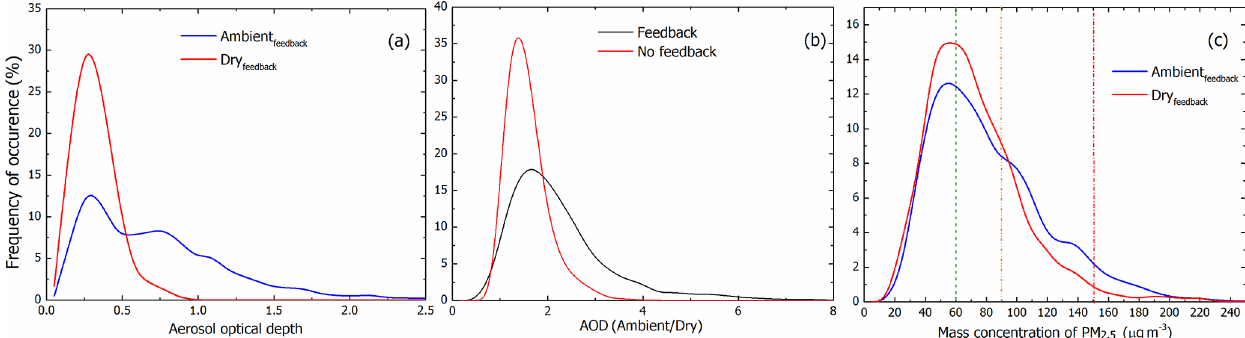
Figure 9. Frequency of occurrence of (a) AOD and (c) PM 2 . 5 for dry and ambient relative humidity conditions with meteorological feedback over the Indo-Gangetic Plain (IGP). (b) The frequency distribution of the ratio of AOD for ambient and dry humidity with and without meteorological feedback. Dotted vertical lines on PM 2 . 5 frequency of occurrence (c) show the breakpoint concentration for the air quality index categories for satisfactory (60µgm − 3 ), moderately polluted (90µgm − 3 ) and poor (150µgm − 3 ) conditions as proposed by the Central Pollution Control Board (CPCB),